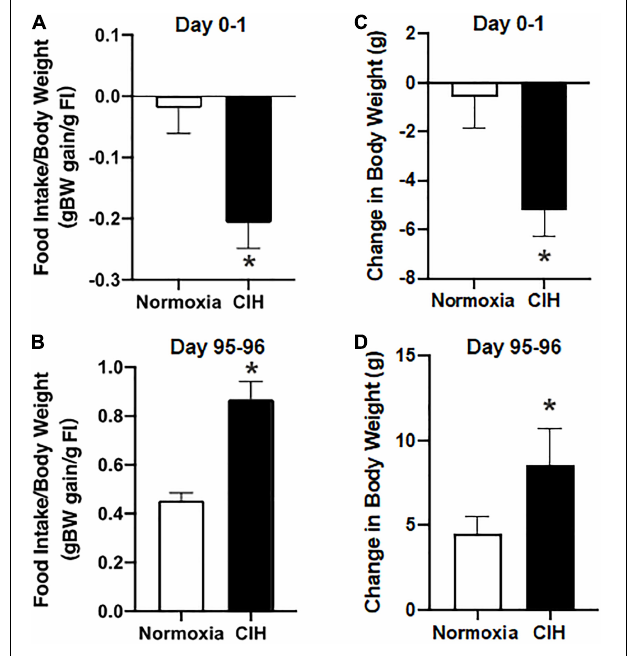
FIGURE 2 | (A,B) Are bar charts showing food conversion efficiency after 1 day and 96-day exposure to CIH or normoxia. exposure. Note that after 1-day exposure to CIH there was a more efficient conversion of food intake, whereas after 96-days of CIH resulted in a less efficient food conversion. n = 16 for each group. (C,D) Are bar charts summarizing the 24 h body weight changes following the 8 h normoxic or CIH exposures during day 0–1 and after days 95–96. Note that immediately after exposure to CIH, there was a 24 h reduction in body weight which by day 96 was reversed in which CIH induced an increase in body weight. n = 16 for each group. Data are shown as mean ± standard error. * p <